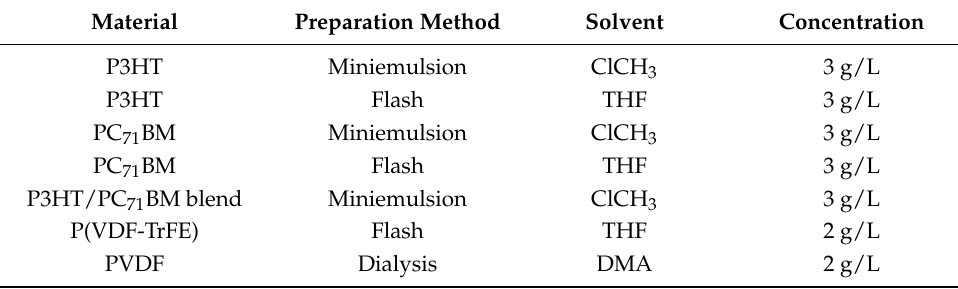
Table 1. Materials and Preparation Methods of Different Functional Polymer Inks. Material Preparation